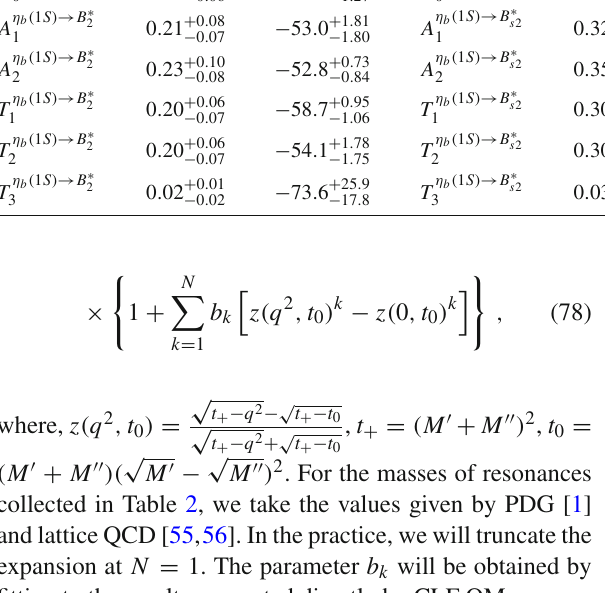
, B ∗ ) transitions with the parameterization scheme given by Eq. s 2 2